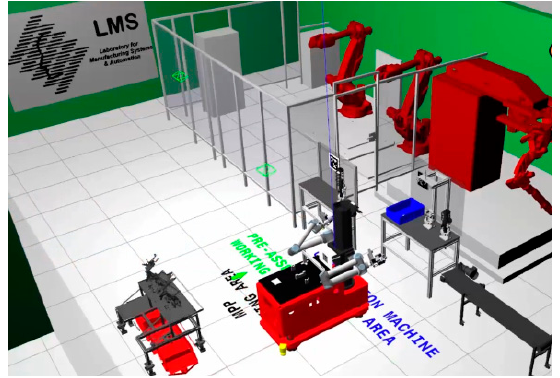
Figure 9. Gazebo simulation .